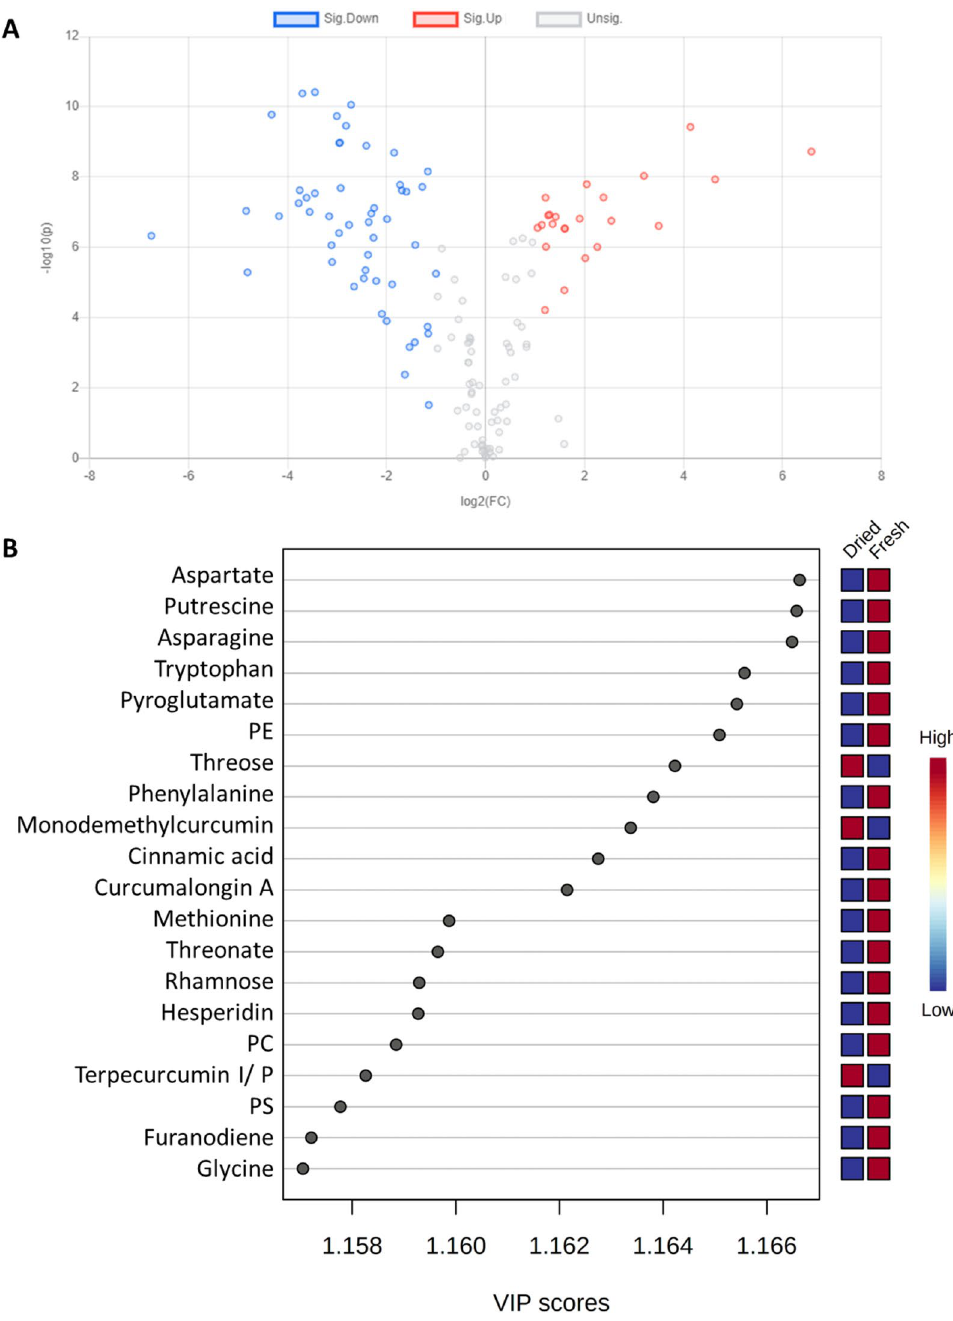
Figure 5. ( A ) Volcano plot showing effect of drying on turmeric rhizomes, where metabolites on the right side (positive side) increased significantly upon drying, while metabolites on the left side (negative side) were more associated with fresh rhizomes. ( B ) VIP scores showing the distribution of potential markers between fresh and dried samples. Colored boxes on right indicate relative abundance of the corresponding metabolite for fresh and dried